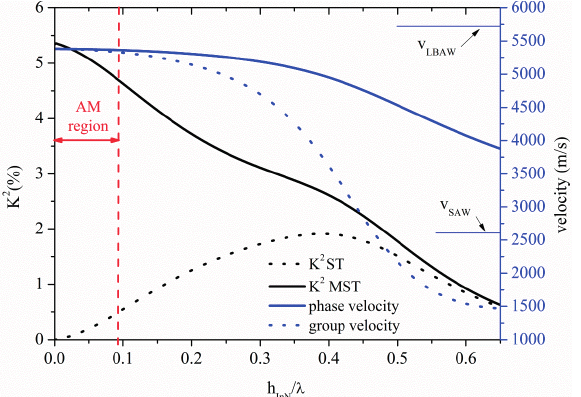
Figure 12. Phase and group velocity, and K 2 dispersion curves of the S 0 mode propagating along the MST and ST configurations on InN